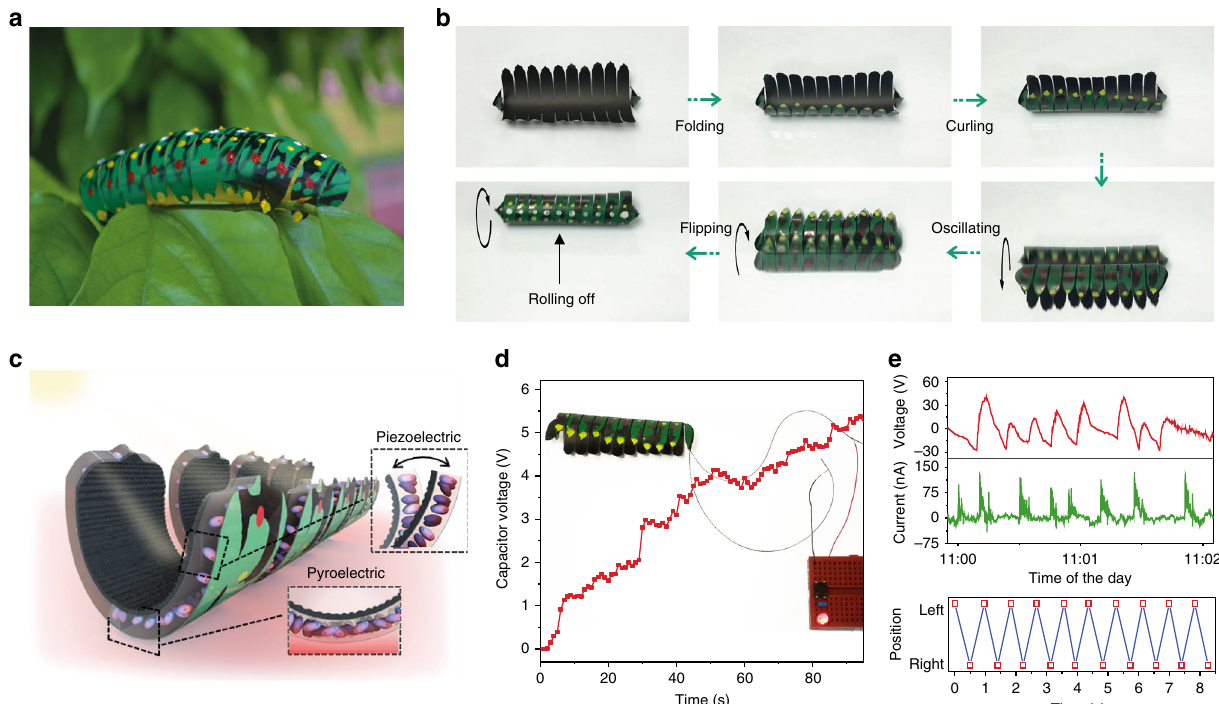
Fig. 6 Power-generating soft TMES-bot imitating self-defensive living organism behaviors. a Photograph of the fabricated TMES-bot. b Active locomotive evolution of TMES-bot for self-defense purpose. c Schematic showing pyro/piezoelectric effects of the power-generating TMES-bot. d Charging characteristic of TMES-bot and an inset photograph of a lighted LED using a charged capacitor. e Open circuit voltage/short circuit current generated by locomotion of TMES on a tiled pavement under an ambient outdoor environment (top) and photothermal-directed cyclic oscillations of the TMES